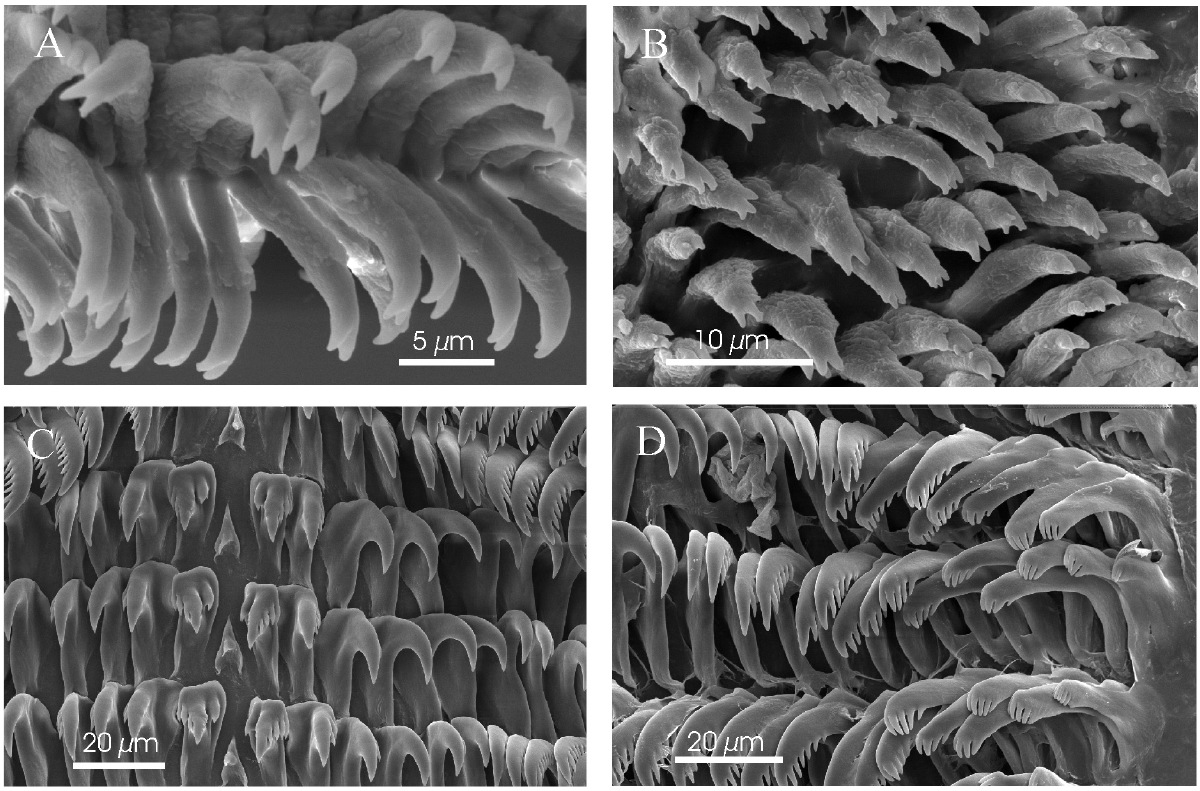
External morphology . Body with pale blue ground colour, deeper on the median part of dorsum; the edge has a very thin red-orange line and there is a broad white-cream band within it (Fig. 1D). There are three longitudinal lines, one median line and two lateral ones, with pale yellow ends and orange areas on the median part of the dorsum. These lines join in the middle where they are deep orange. Small rays arise from the lateral lines and the central line divides into two rays in front of the gills. There are five unipinnated violet pinkish gills, with violet rachis. The posterior gills are paler. The